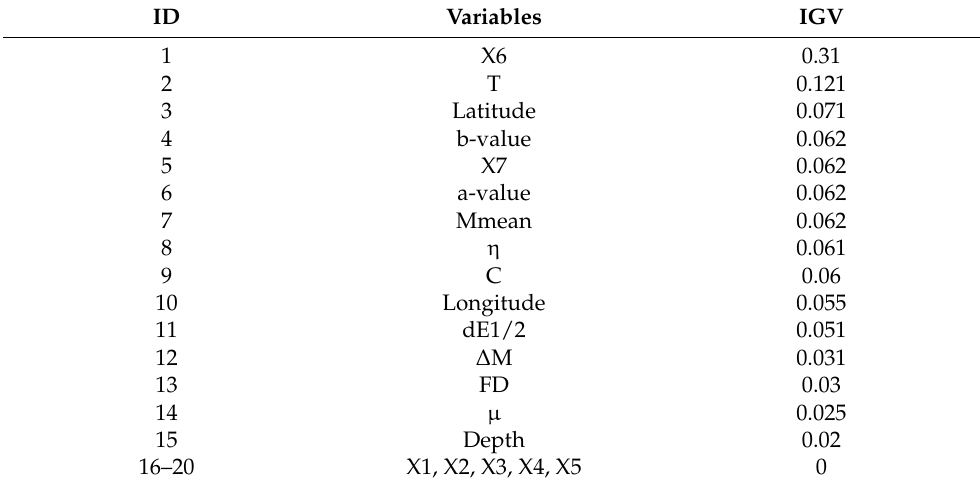
Table 4. Information Gain Value (IGV) for the input variables.